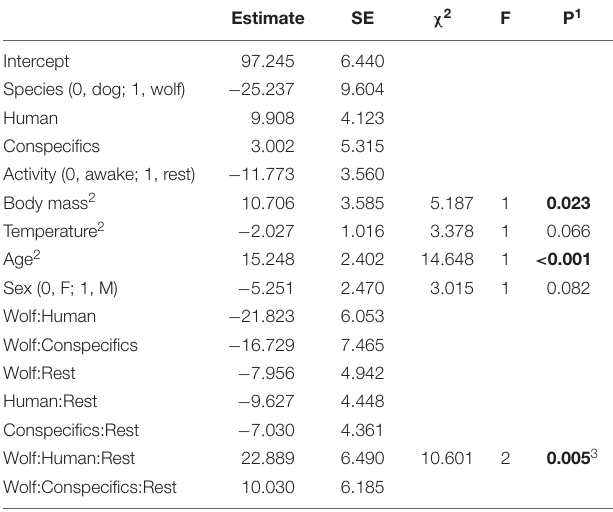
TABLE 2 | Results of the HR Model. Estimate SE χ 2 F P